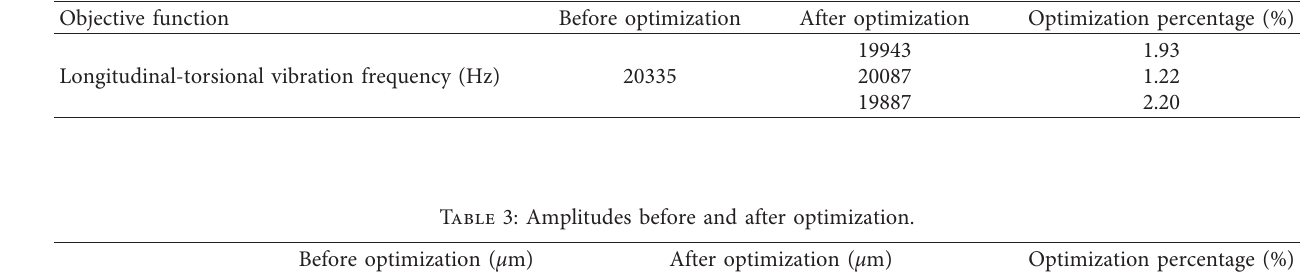
Table 2: Longitudinal-torsional vibration frequency before and after optimization.